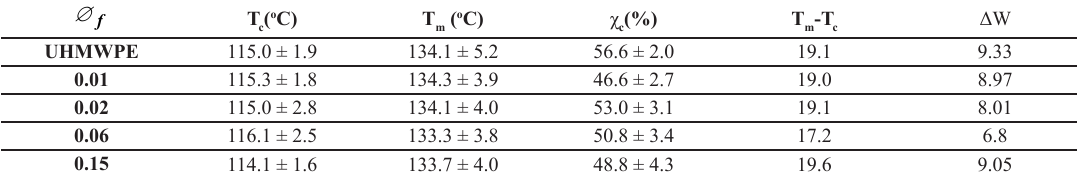
Table 2. DSC results for UHMWPE and its composites upon second heating. ∅ f